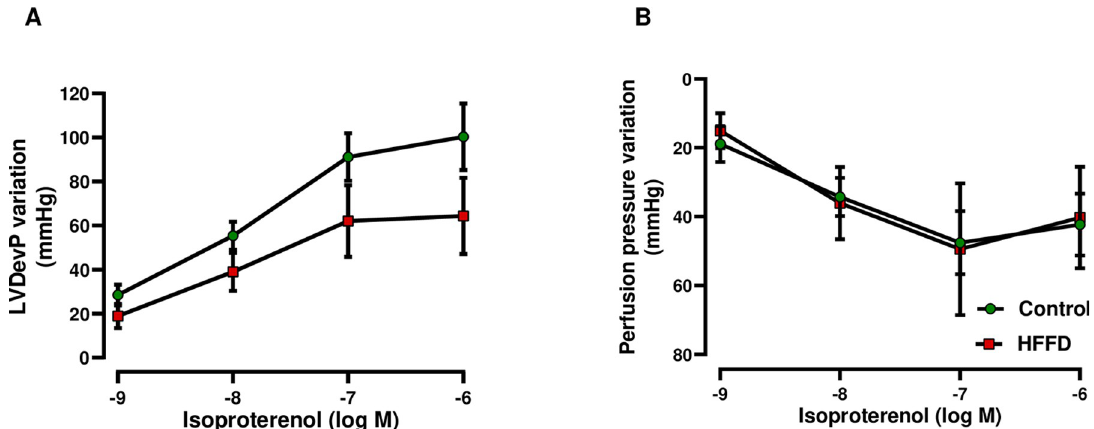
Fig 2. Effects of ß-adrenoceptor stimulation on cardiac function. Cardiac parameters were assessed after ß-adrenoceptor stimulation by building non-CCRCs to isoproterenol (10 − 9 to 10 − 6 M). The (A) LVDevP (left ventricular developed pressure) and (B) perfusion pressure, reflecting cardiac inotropy and coronary vasodilation, respectively, were evaluated. Data are represented as mean ± SEM and are analyzed using LME analysis (n = 6 for Control and n = 6 for